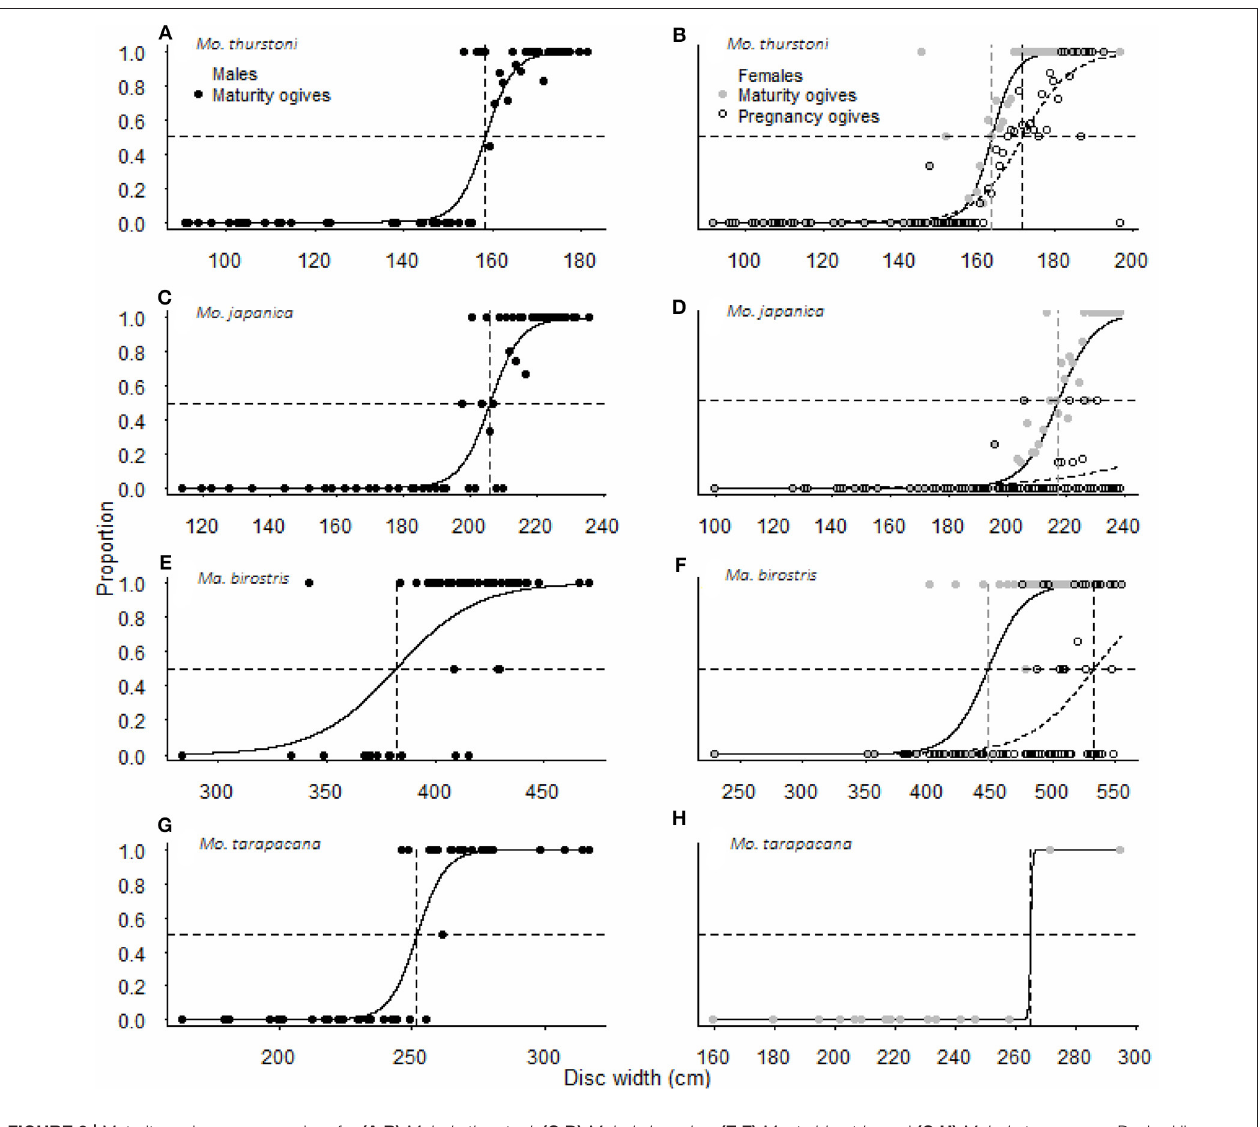
FIGURE 3 | Maturity and pregnancy ogives for (A,B) Mobula thurstoni , (C,D) Mobula japanica , (E,F) Manta birostris , and (G,H) Mobula tarapacana . Dashed lines are disc widths for DW 50 values. Statistical quantities values of parameters and statistical quantities for the equation P = P max  summarized in Table 5 . DW the total size, P the proportion of specimens at DW, DW 50 the size at which 50% of the population is mature or pregnant, DW 95 the size at which 95% of the population is mature or pregnant.